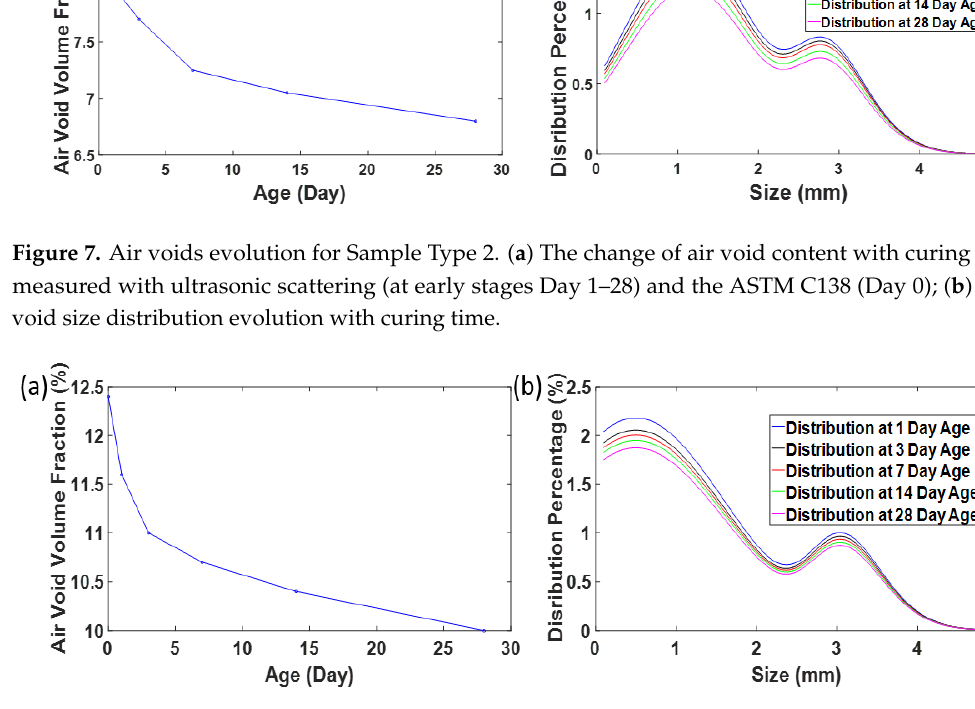
Table 2. Properties of concrete samples during the early stages.